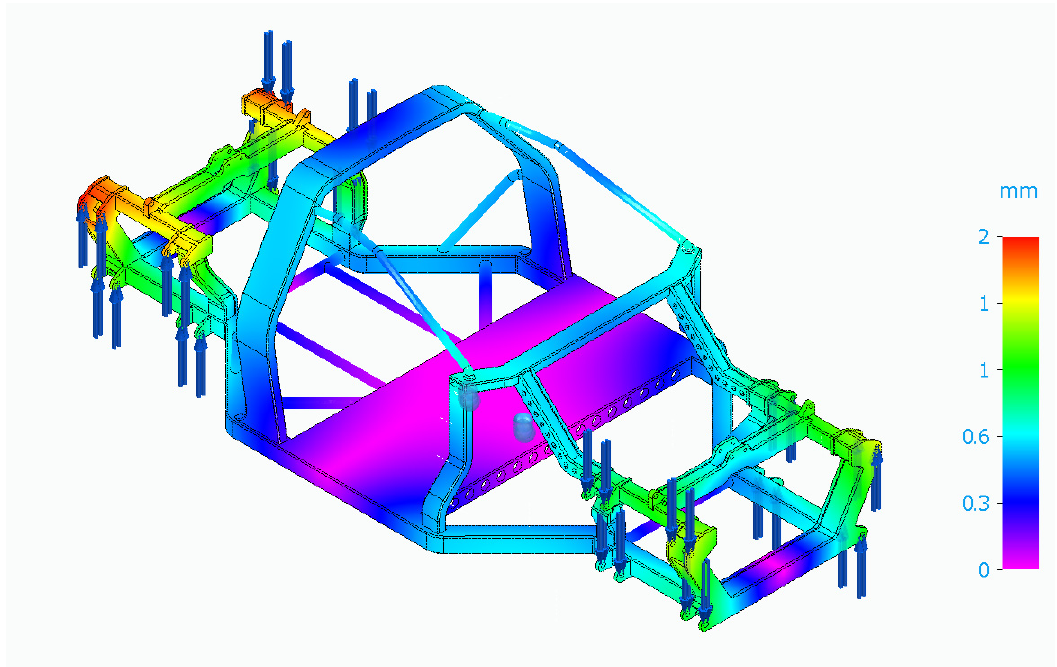
Figure 26. FEM Analysis for torsional stiffness.